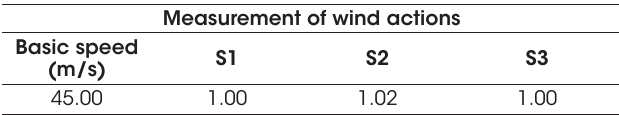
Data used to calculate wind